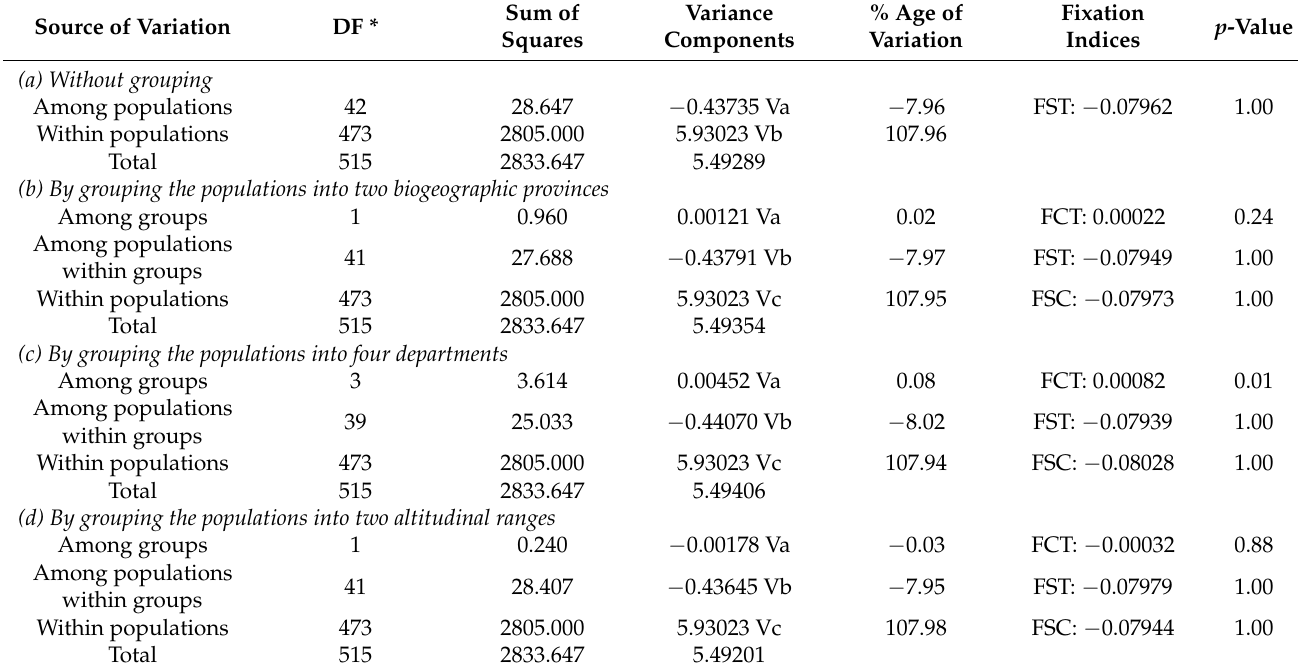
Table 5. AMOVA calculated for 43 populations (a) without grouping, (b) grouped into two biogeo- graphic provinces (xerophytic and mesophytic Puna), (c) grouped into four departments (Oruro, La Paz, Potosi, Cochabamba) and (d) grouped into two altitudinal ranges (<3800 masl and ≥ 3800